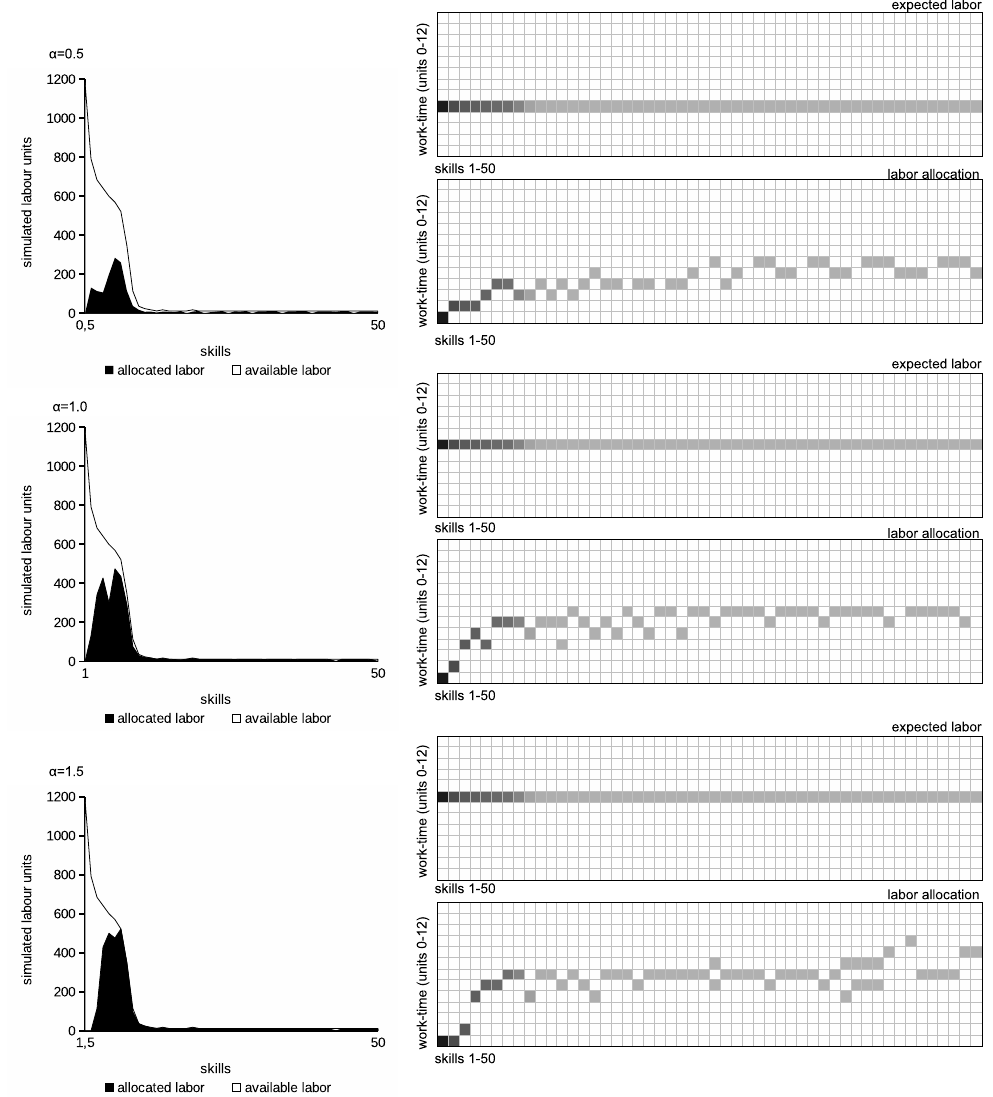
Figure 4. Labor allocation for different α parameters’